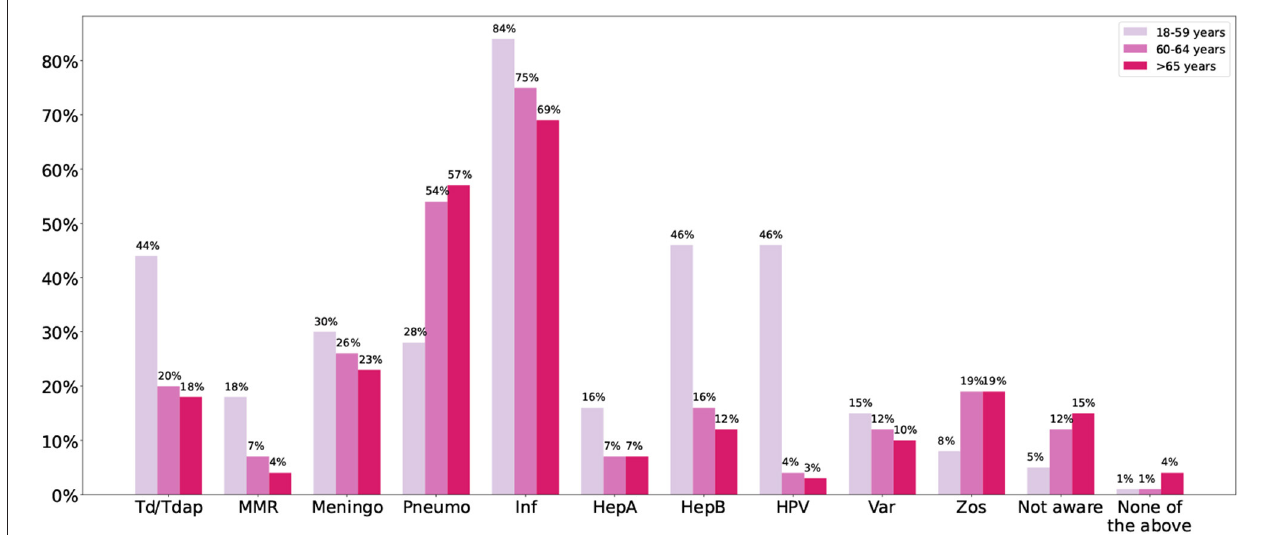
FIGURE 1 | The figure shows the percentage of physicians that would recommend each vaccine for the different age groups. Meningo, meningococcal; Pneumo, pneumococcal; Inf, influenza; HepA, hepatitis A; HepB, hepatitis B; Var, varicella; Zos,